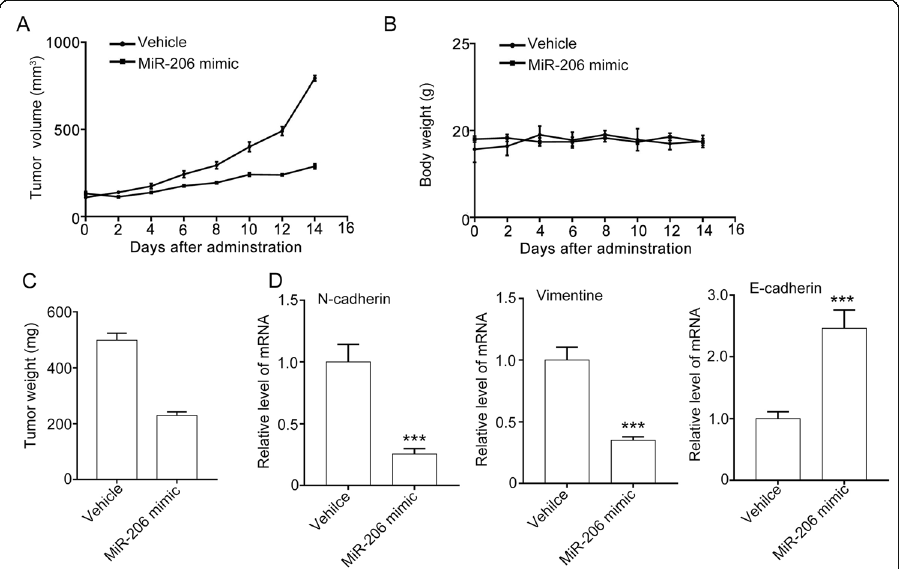
Fig. 5 MiR-206 suppresses tumor growth of A549 xenograft mouse model. ( a and b ) MiR-206 inhibited A549 xenograft tumor growth. A549 cells suspended in PBS were injected subcutaneously into 5- to 6- week-old BABL/c (nu/nu) male mice to establish the xenograft. Then the mice were divided into the NC mimic group and miR-206 mimic group. The tumor volumes were measured by a slide caliper. At the end of the experiment, tumors were removed and frozen. The tumor volume curve and tumor weight are shown in a and b , respectively. c MiR-206 suppressed mRNA of EMT marker in tumor. Quantitative data are presented as mean ± SEM. * **P < 0.001 compared with the NC mimic